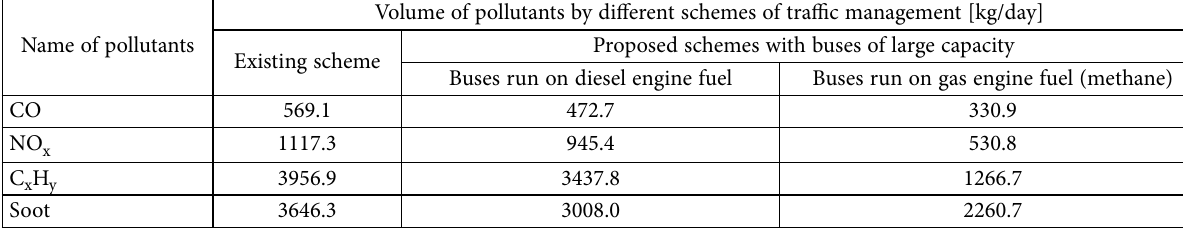
Table 1. Volume of pollutants